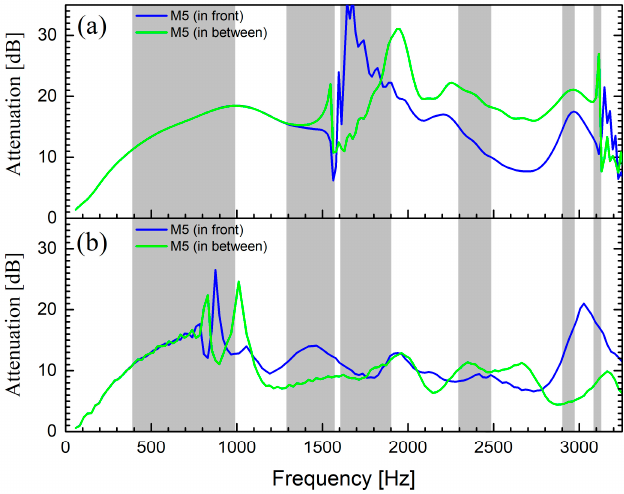
Figure 7. Attenuation spectra calculated for an acoustic barrier consisting of three rows of absorptive cylinders arranged in a square configuration with a lattice constant of 22 cm and a volume filling ratio of 41%. ( a ) Results for incident plane waves; ( b ) results for impinging cylindrical waves. Grey zones define band gaps along Γ X orientation (see Figure 4) of the barrier.